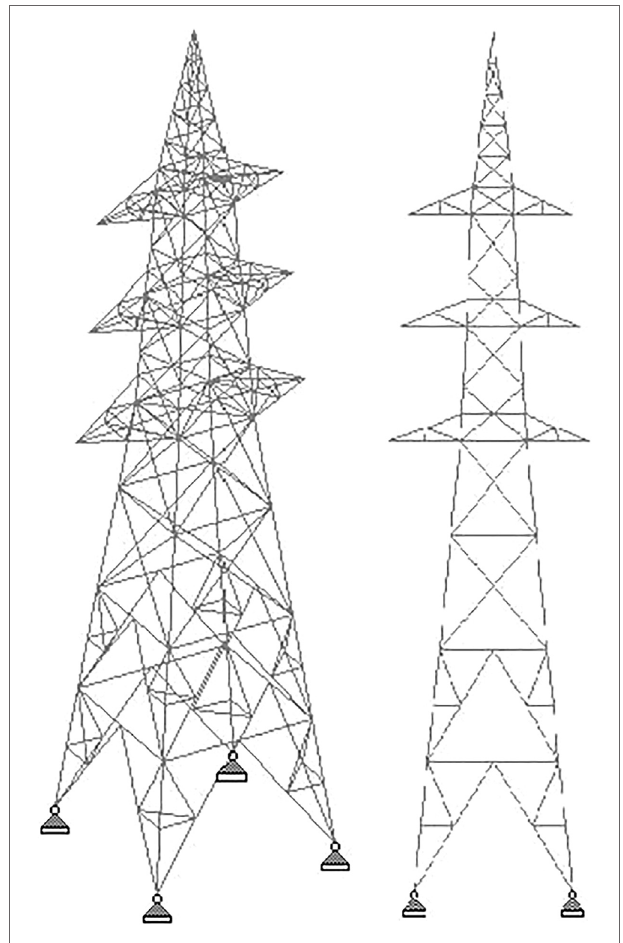
FigUre 1 | Views of the transmission tower selected as case study